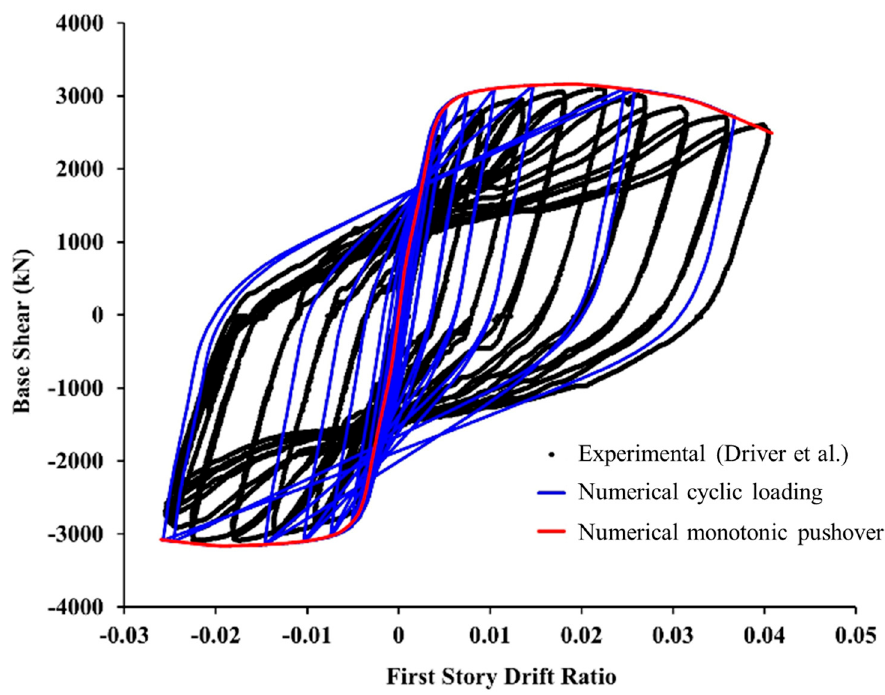
Figure 12. Comparison between numerical and experimental pushover curves for the four-story specimen by Driver et al. [57].